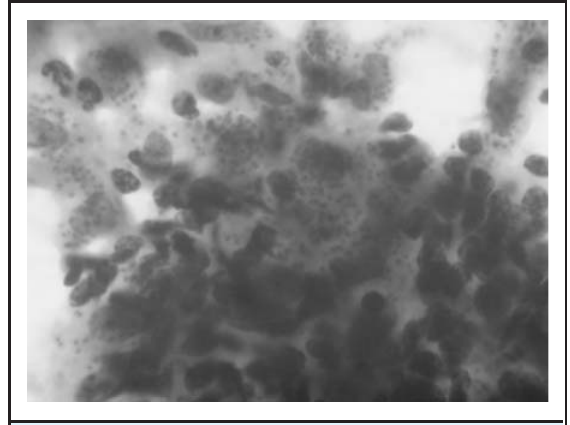
Figure 1. (cid:2)(cid:3)(cid:4)(cid:5)(cid:6)(cid:7)(cid:8)(cid:6)(cid:9)(cid:3)(cid:10)(cid:11) (cid:12)(cid:5)(cid:8)(cid:13)(cid:14)(cid:15)(cid:11) (cid:16)(cid:9)(cid:6)(cid:17)(cid:11) (cid:9)(cid:5)(cid:5)(cid:11) (cid:18)(cid:15)(cid:4)(cid:3)(cid:15)(cid:18)(cid:11) (cid:19)(cid:20)(cid:7)(cid:18)(cid:15)(cid:7)(cid:21)(cid:11) and central ulcer with indurated base in the skin over the anterior neck superior to cricoid region measuring about 4x2 cm.